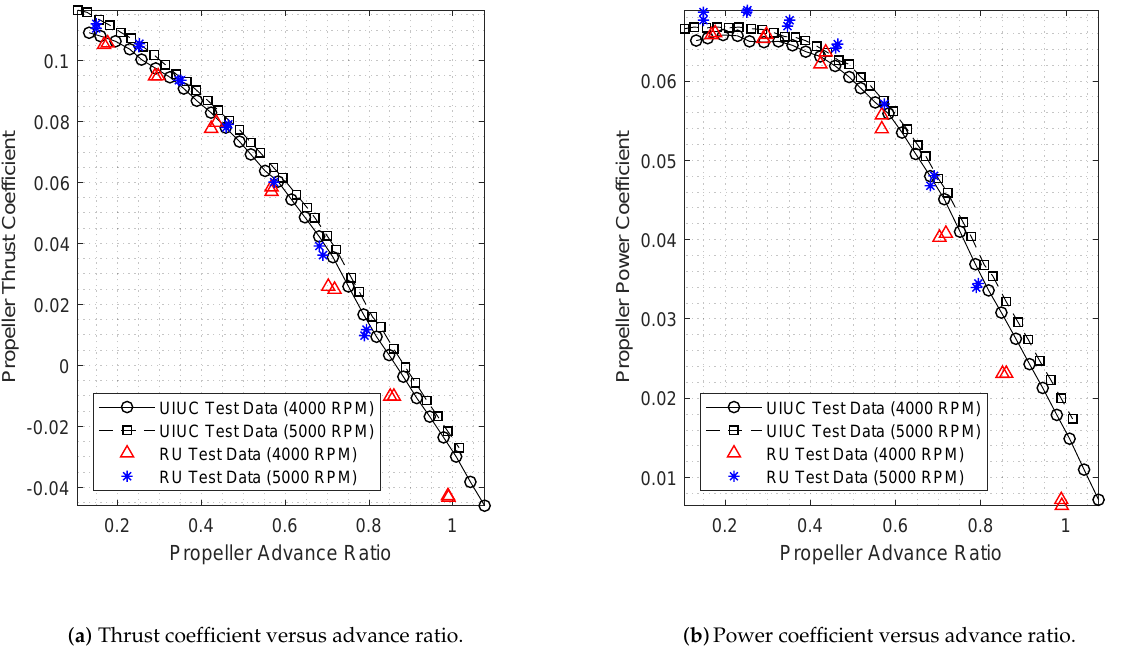
Figure 3. Comparison between UIUC and RU wind-tunnel test data for the Master Airscrew 11x7E propeller.